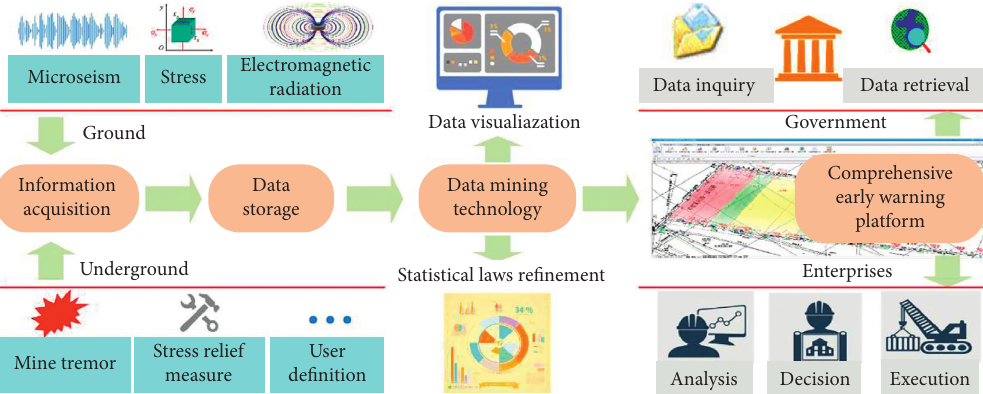
Figure 9: Rock burst comprehensive advance warning